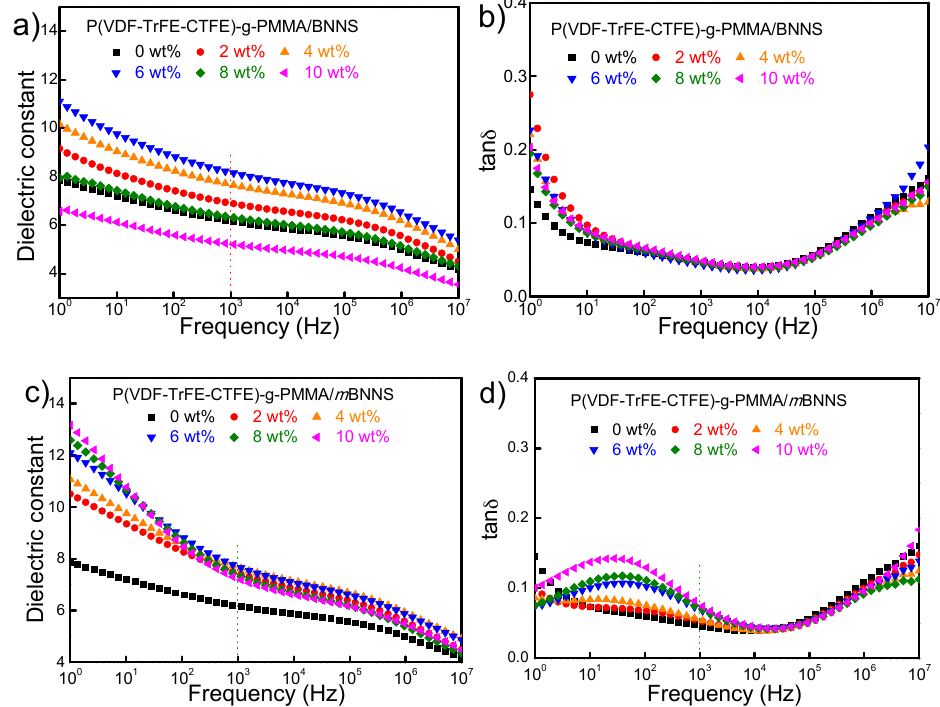
Figure 6. Frequency dependence of ( a , c ) dielectric constant and ( b , d ) dielectric loss of the composites with different particle contents under room temperature.